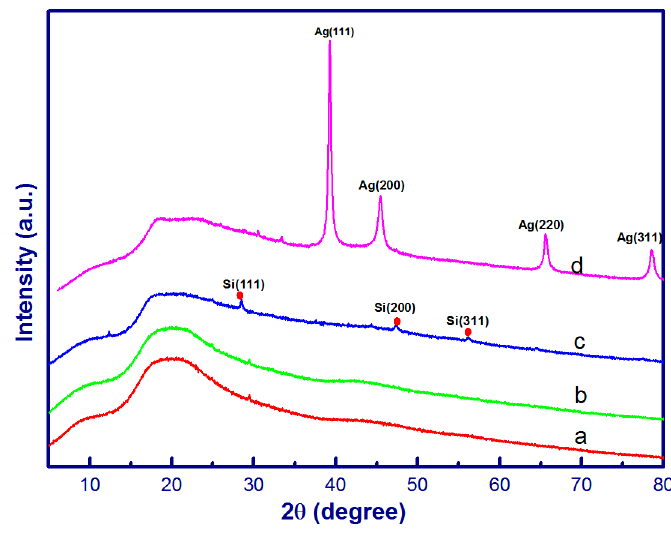
Figure 3. XRD patterns of PAN ( a ); PAN/CNC/Ag ( b ); PAN/CNC/Ag/Si ( c ); and p-PAN/CNC/Ag ( d ).